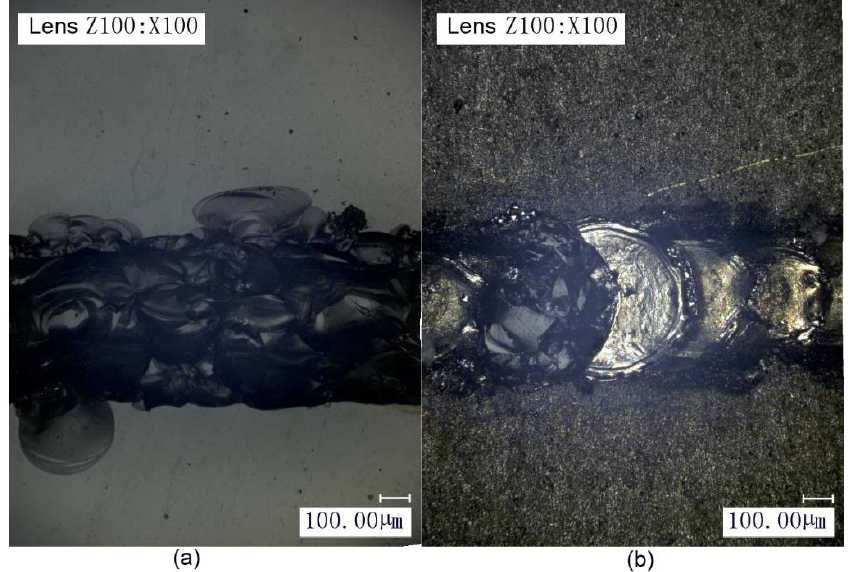
Figure 6. Micrographs of titanium alloy and high borosilicate glass using laser voltage for transmission welding of 440 V: ( a ) glass and ( b ) titanium alloy.